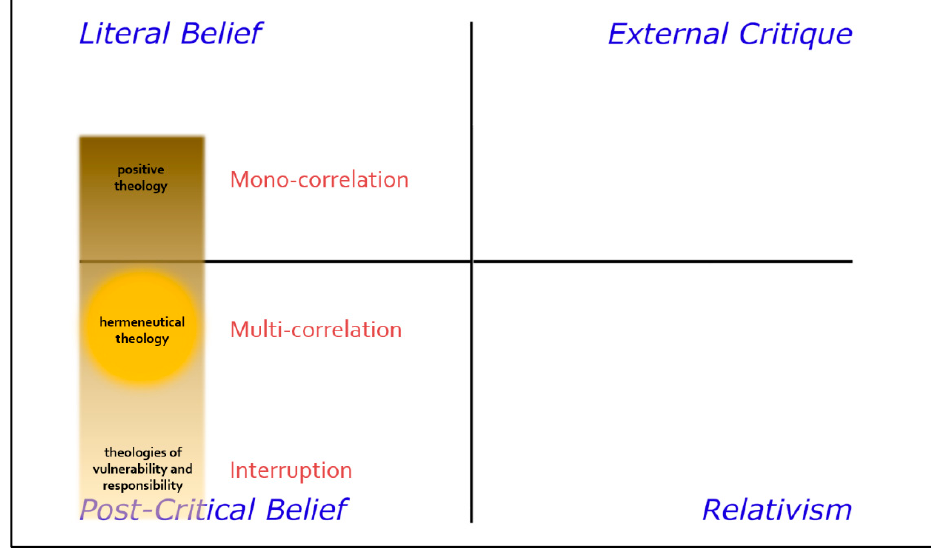
Figure 8. A continuum between positive and negative theology.